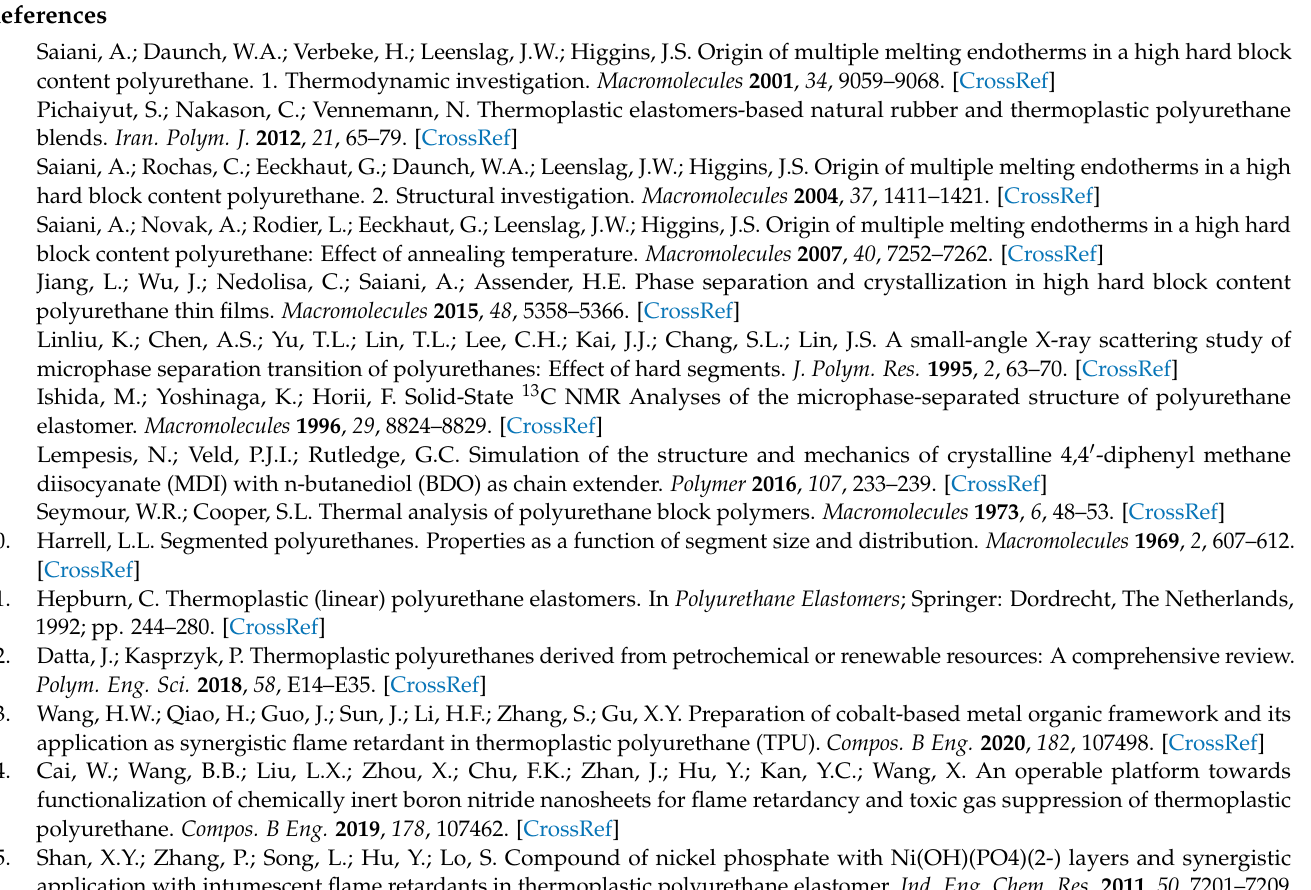
Figure S3. Digital photograph of the equipment of thermogravimetry analysis test; Figure S4. Digital photograph of cone calorimeter test process of TPU with PEPE; Figure S5. Digital photographs of the equipment of limiting oxygen index